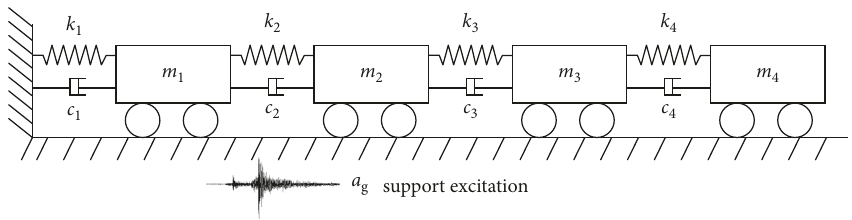
Figure 3: Concentrated mass system with 4 degrees-of-freedom.